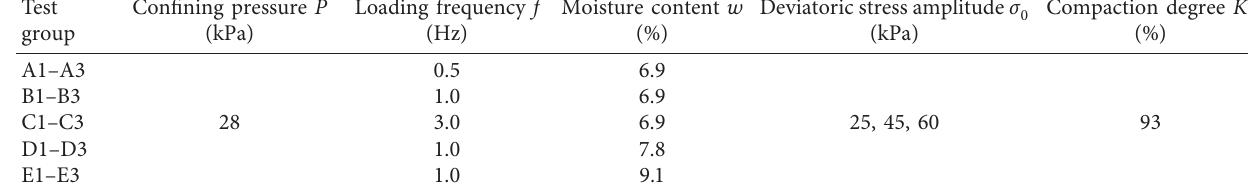
Figure 3: Numerical sample for dynamic triaxial test. (a) 3D view. (b) Vertical cross section. (c) Horizontal cross section. Table 3: Simulation scheme for dynamic triaxial tests.